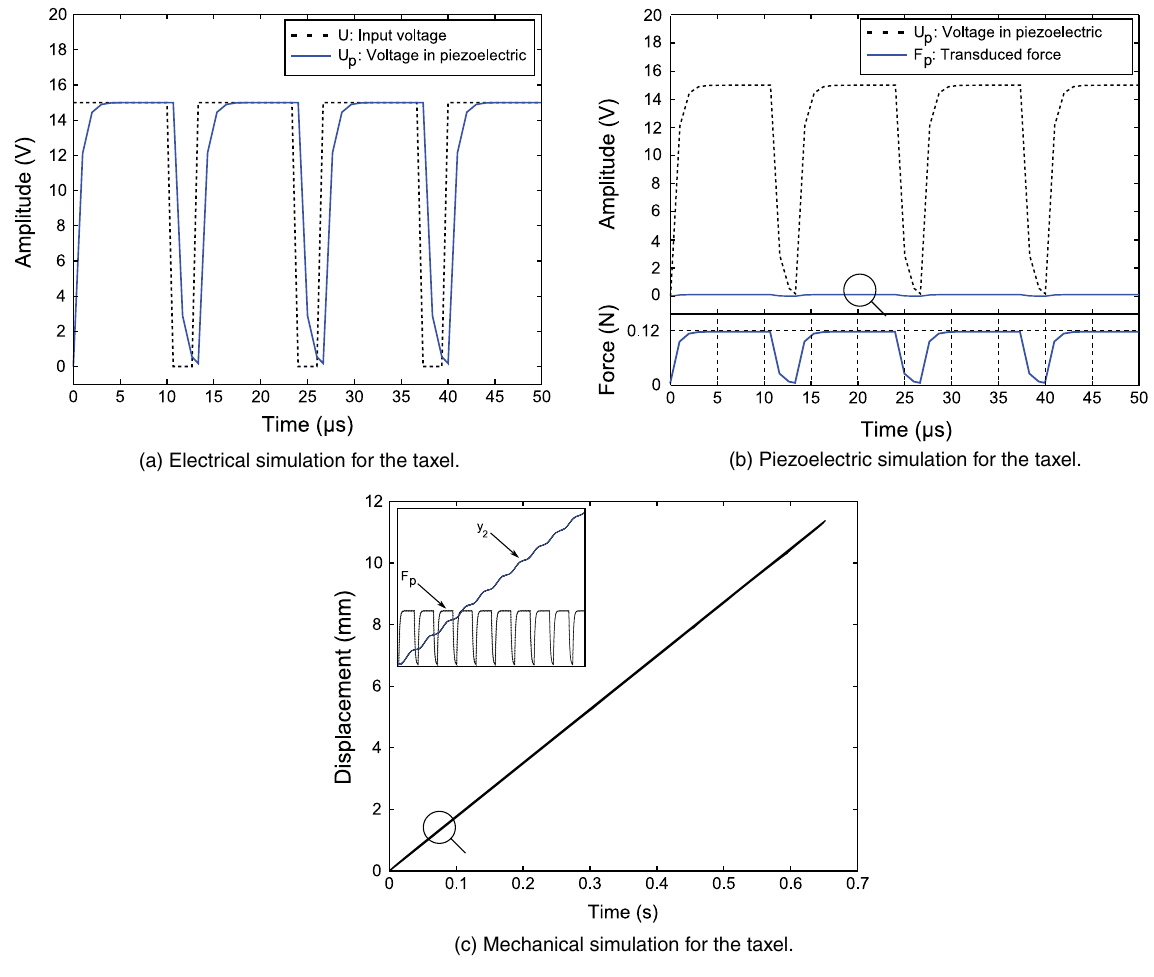
Fig. 9. Numerical simulation relations for the piezoelectric